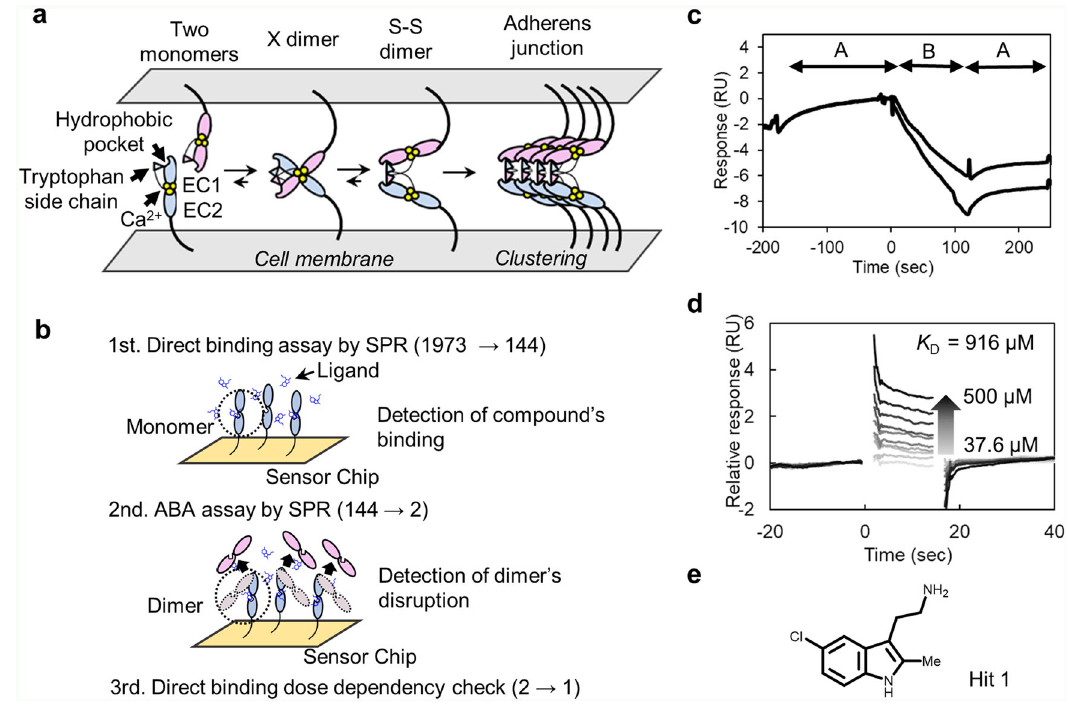
Fig. 1 SPR-based fragment screening. a Illustration of the stepwise dimerization of P-cadherin to mediate cell adhesion and a schematic of the protein (EC12). b Schematic of fragment screening. The numbers in the parentheses show decreases in the number of fragment candidates. c Representative sensorgram from ABA assay. EC12, in monomer-S – S dimer equilibrium, was immobilized on Sensor Chip CM5. The decrease of response upon injection of solution B shows that the compound disrupted the dimer formed on the sensor chip. d Dose – response analysis of binding of Hit 1 to REC12 immobilized on Sensor Chip SA. The putative K D was calculated by the Scatchard method using the SPR responses in equilibrium. Note that the K D value is not reliable, since the binding response was not saturated even at the highest concentration of Hit 1. N = 3. e Chemical structure of Hit